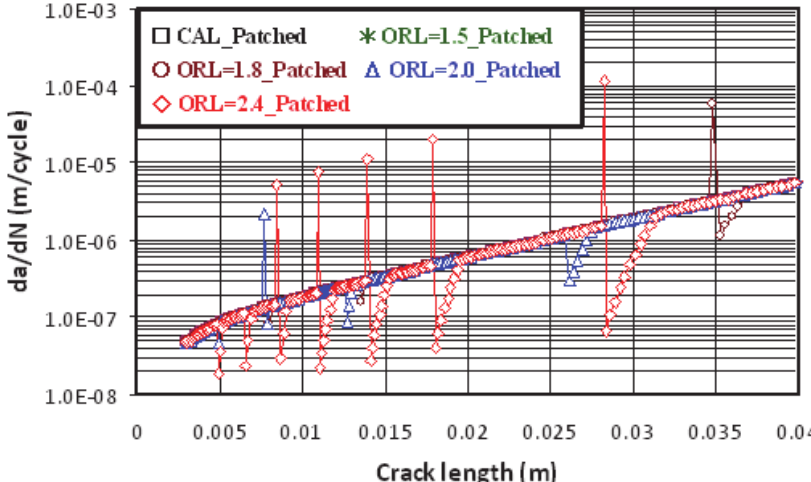
Figure 6: Overload ratio effect on crack growth rates for repaired 2024 T351 Al-alloy plate. The relationships between retard ratio “ D CAL